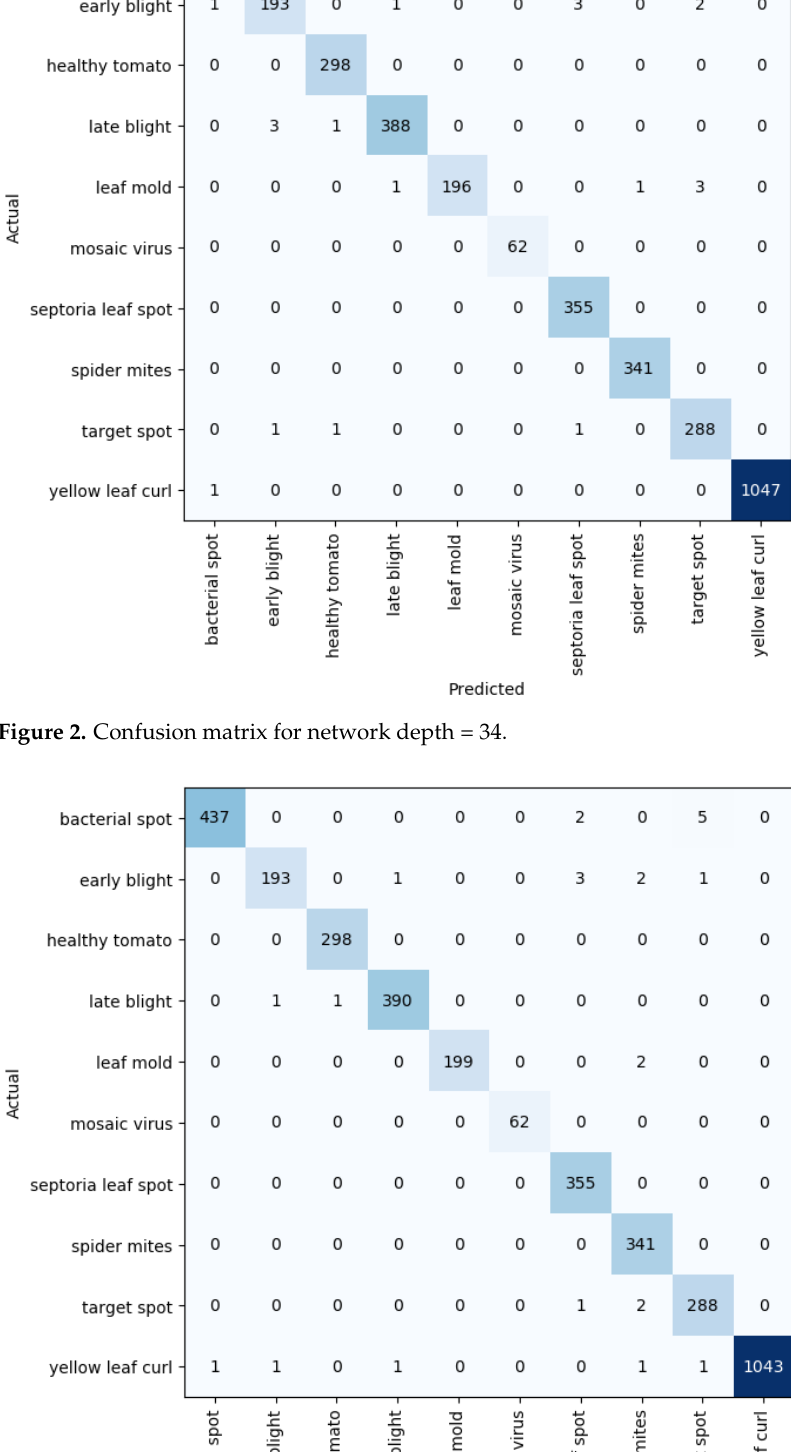
( f ) Figure 1. Showing the results on different train/test split ratios on various models used in our re- search: ( a ) showing epoch over F1 score for ResNet-18; ( b ) showing epoch over F1 score for ResNet- 34; ( c ) showing epoch over F1 score for ResNet-50; ( d ) showing epoch over F1 score for ResNet-101; ( e ) showing epoch over F1 score for ResNet-152; ( f ) showing epoch over F1 score for ResNet-152 on